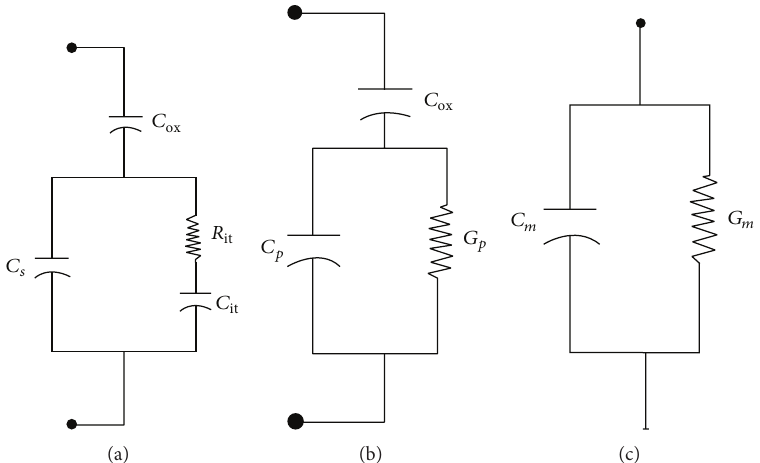
= 𝑅 𝐶 , (b) simplified circuit it it it